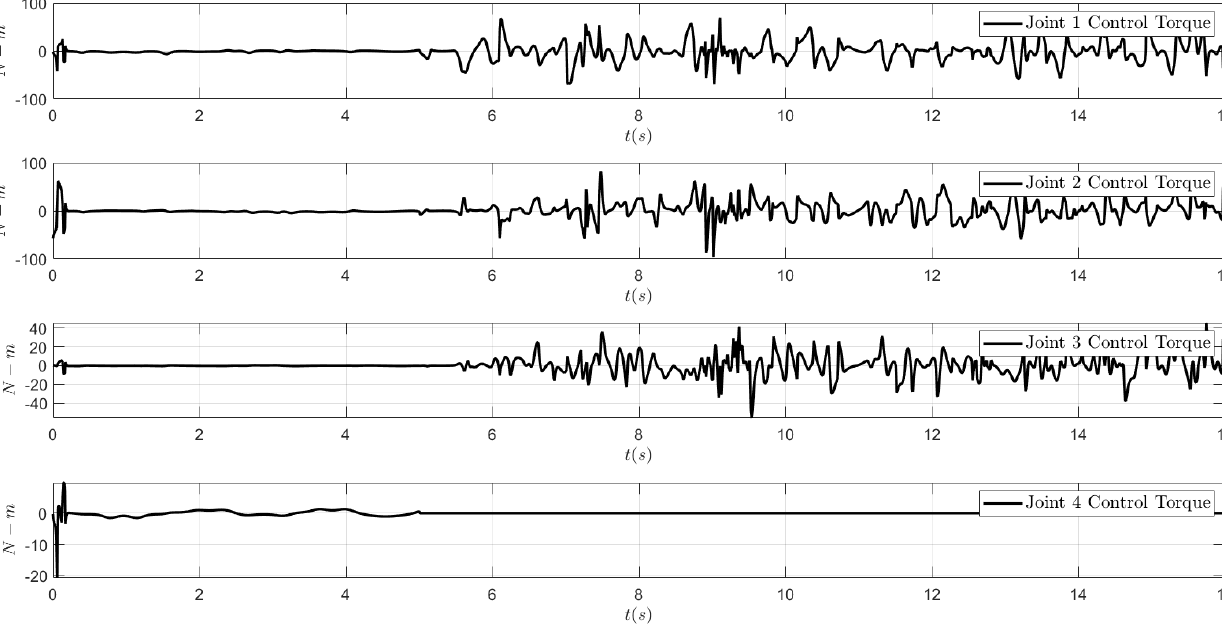
Figure 6. Control signal without adaptive chaos